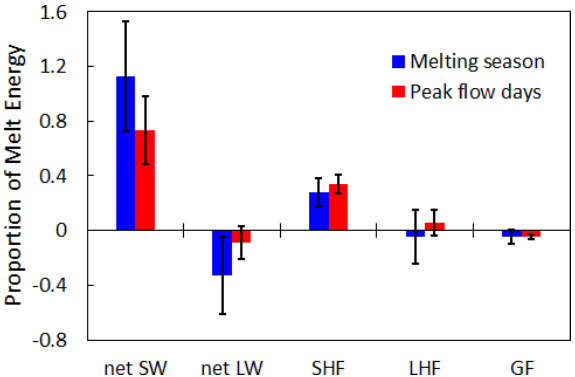
Figure 8. Proportion of melt energy (ratio of each component to total melt energy) for the whole melt season in blue and for the days during the melt episodes only in red. Here, peak flow days in- clude days from the second melt episode (19–23 June) and the third melt episode (16–20 July). Error bars represent standard deviation of each sample. net SW – net shortwave radiation; net LW – net longwave radiation; SHF – sensible heat flux; LHF – latent heat flux; GF – ground heat